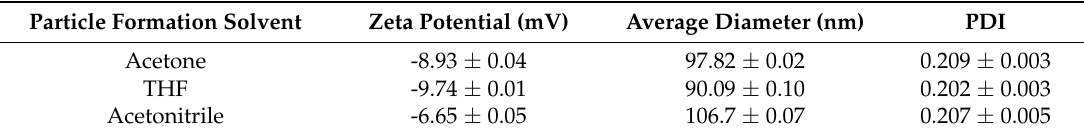
Figure 5. Diameter size distributions obtained from DLS for encapsulated ZnPcBCH 3 nanoparticles prepared in THF ( A ), acetone ( B ) and acetonitrile ( C ) media in the nanoprecipitation process, and TEM data for nanoparticles in acetonitrile ( D ). Table 3. Characterization of PEG-b-PLGA nanoparticles formed in different solvents. Results represent mean ± SD ( n = 3).